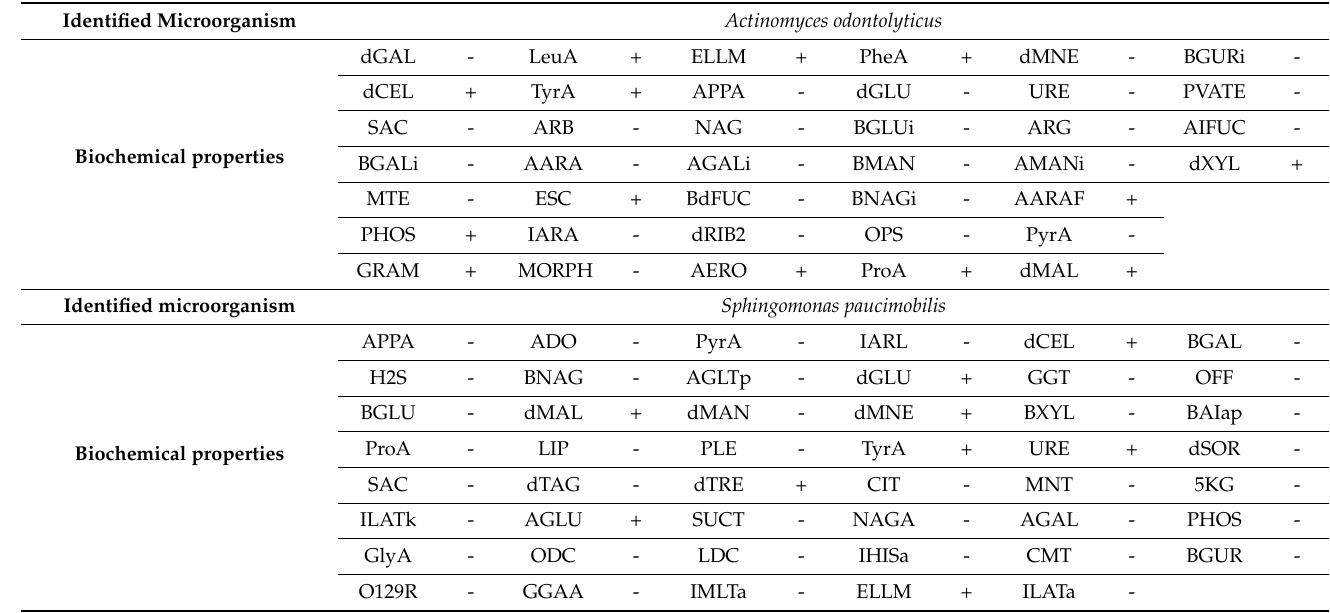
Table 2. Pathogens identified using the VITEK 2, including the biochemical information for the identification of the isolated